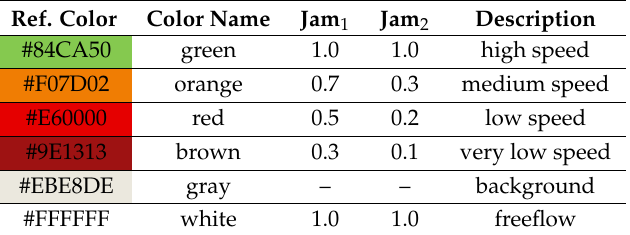
Table 1. Color map used to extract travel